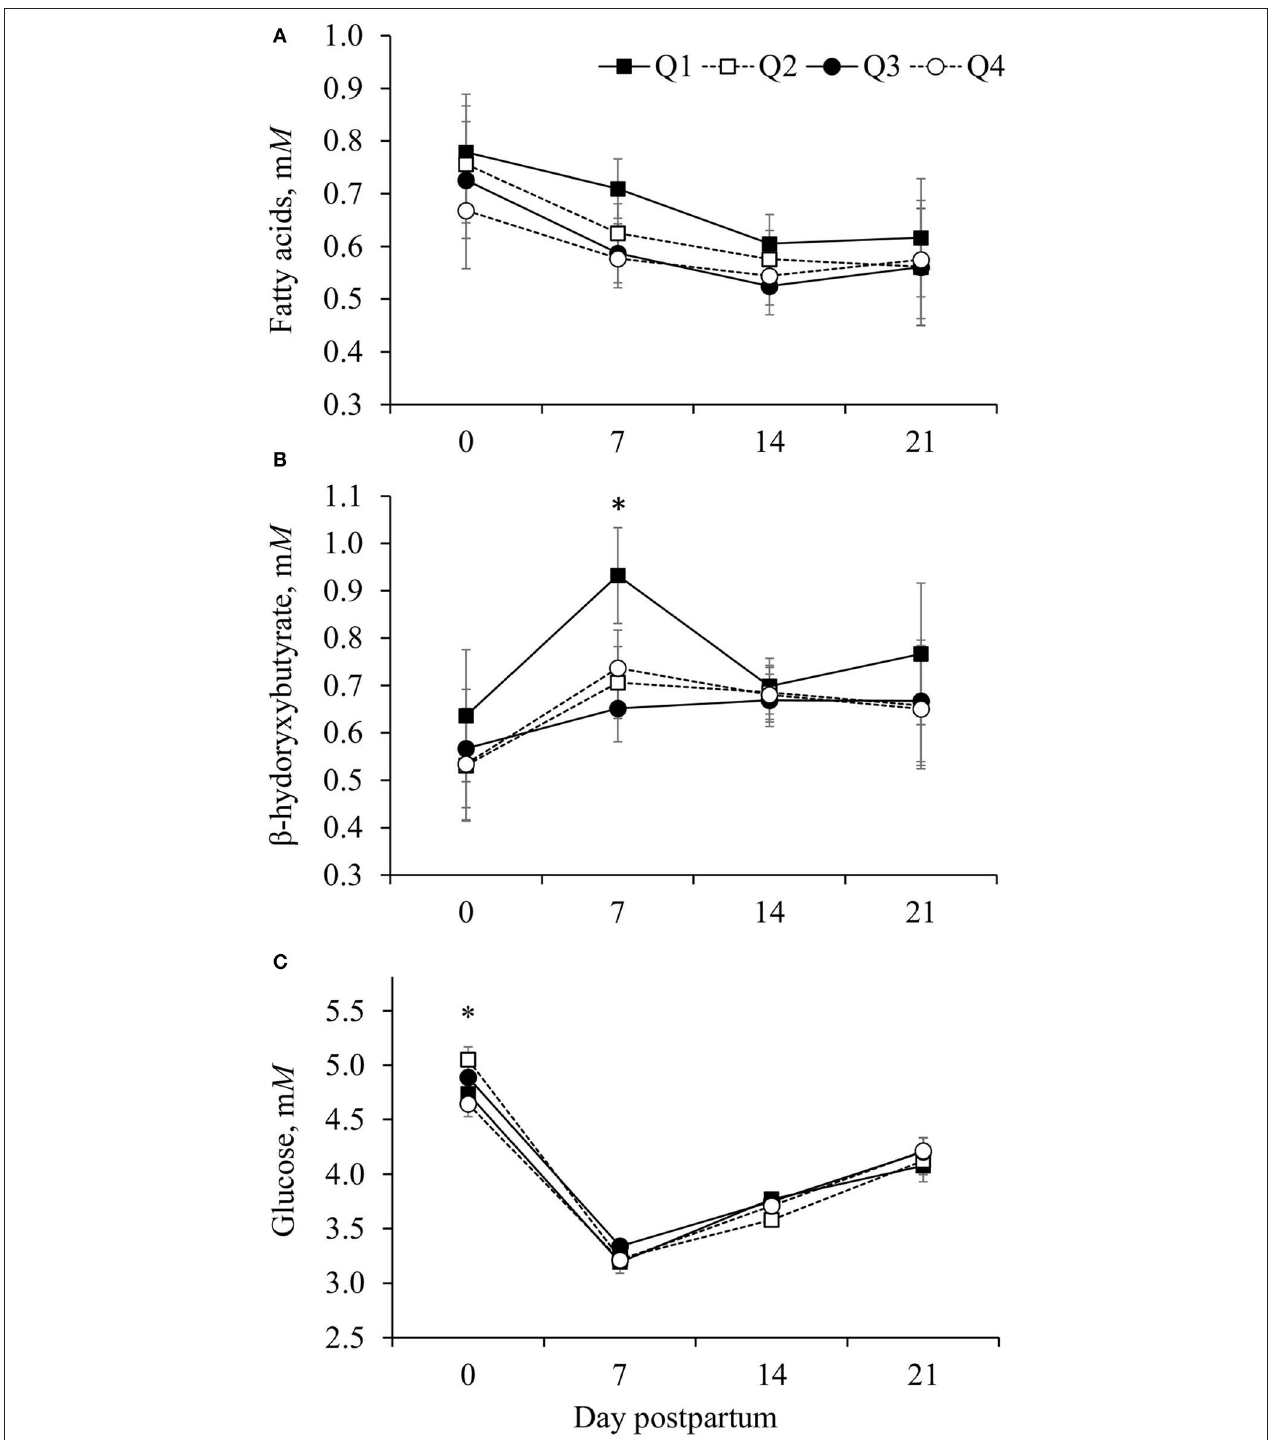
FIGURE 1 | Concentrations of fatty acids (A) , β - hydroxybutyrate (B) , and glucose (C) in the plasma of Holstein cows according to quartile of residual dry matter (DM) intake [residual feed intake (RFI)]. Residual DM intake was calculated from 1 to 105 days postpartum based on the difference between observed and predicted DM intake, and cows were grouped into quartiles (Q1, the smallest RFI, to Q4, the largest RFI). Predicted DM intake was calculated following a statistical model that considered net energy for lactation (NEL) secreted as milk, metabolic BW, body energy change, parity group, and treatment nested within the experiment. (A) The effect of RFI quartile ( P = 0.003) and interaction between RFI quartile and day postpartum ( P = 0.26). (B) The effect of RFI quartile ( P = 0.001) and interaction between RFI quartile and day postpartum ( P = 0.002). (C) The effect of RFI quartile ( P = 0.47) and interaction between RFI quartile and day postpartum ( P = 0.06). Error bars represent the SEM. Within day postpartum, *denotes difference among quartiles ( P < 0.05).